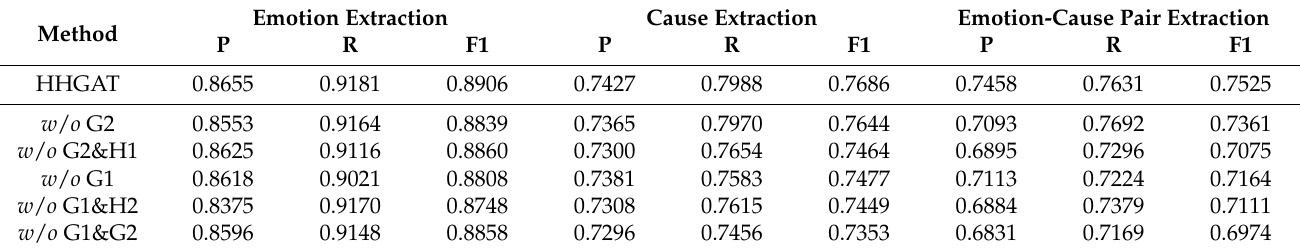
Table 2. Experimental results of structural